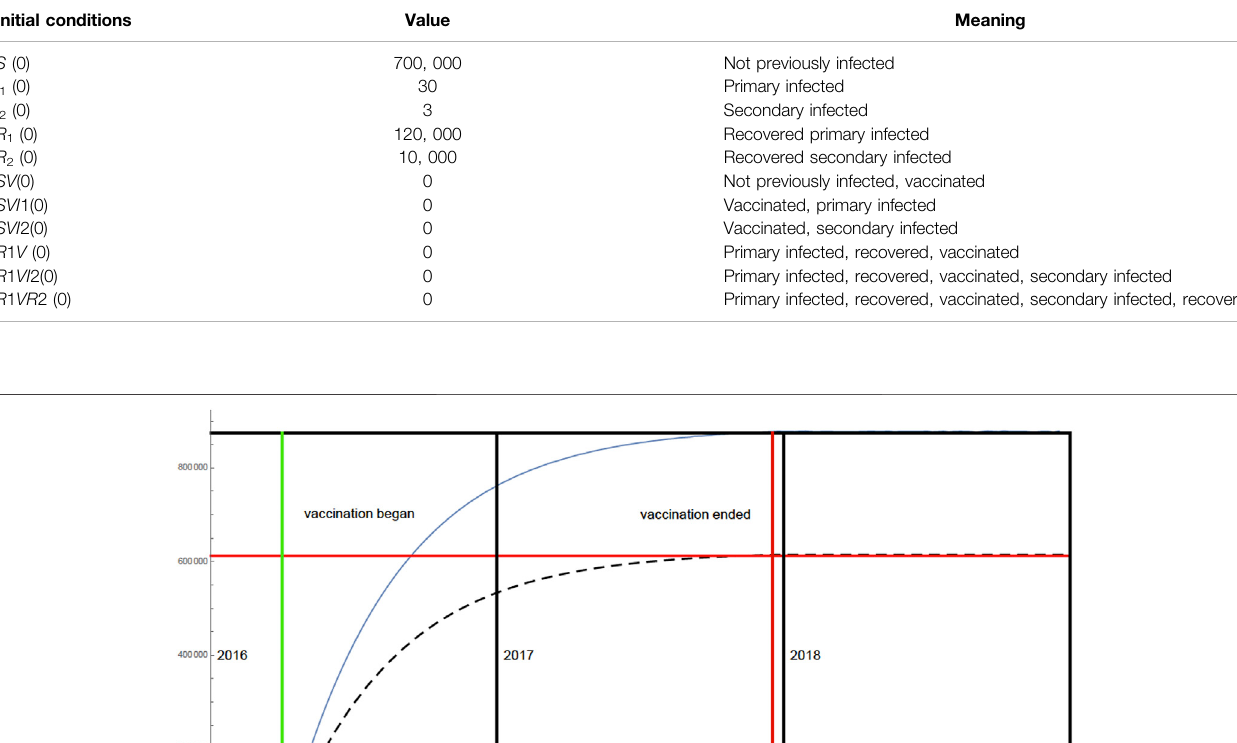
Frontiers in Applied Mathematics and Statistics |